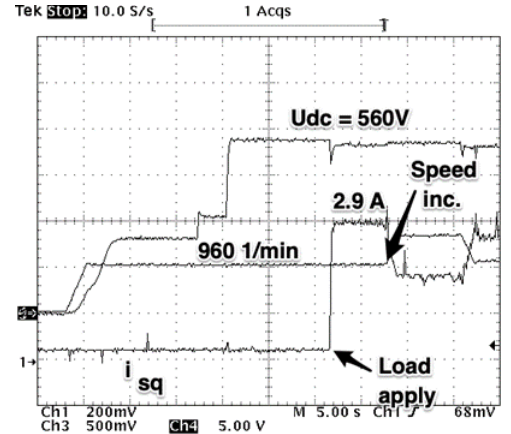
Fig. 4. Waveforms of DC voltage, active current, with load apply application and load shedding during rotational speed changes